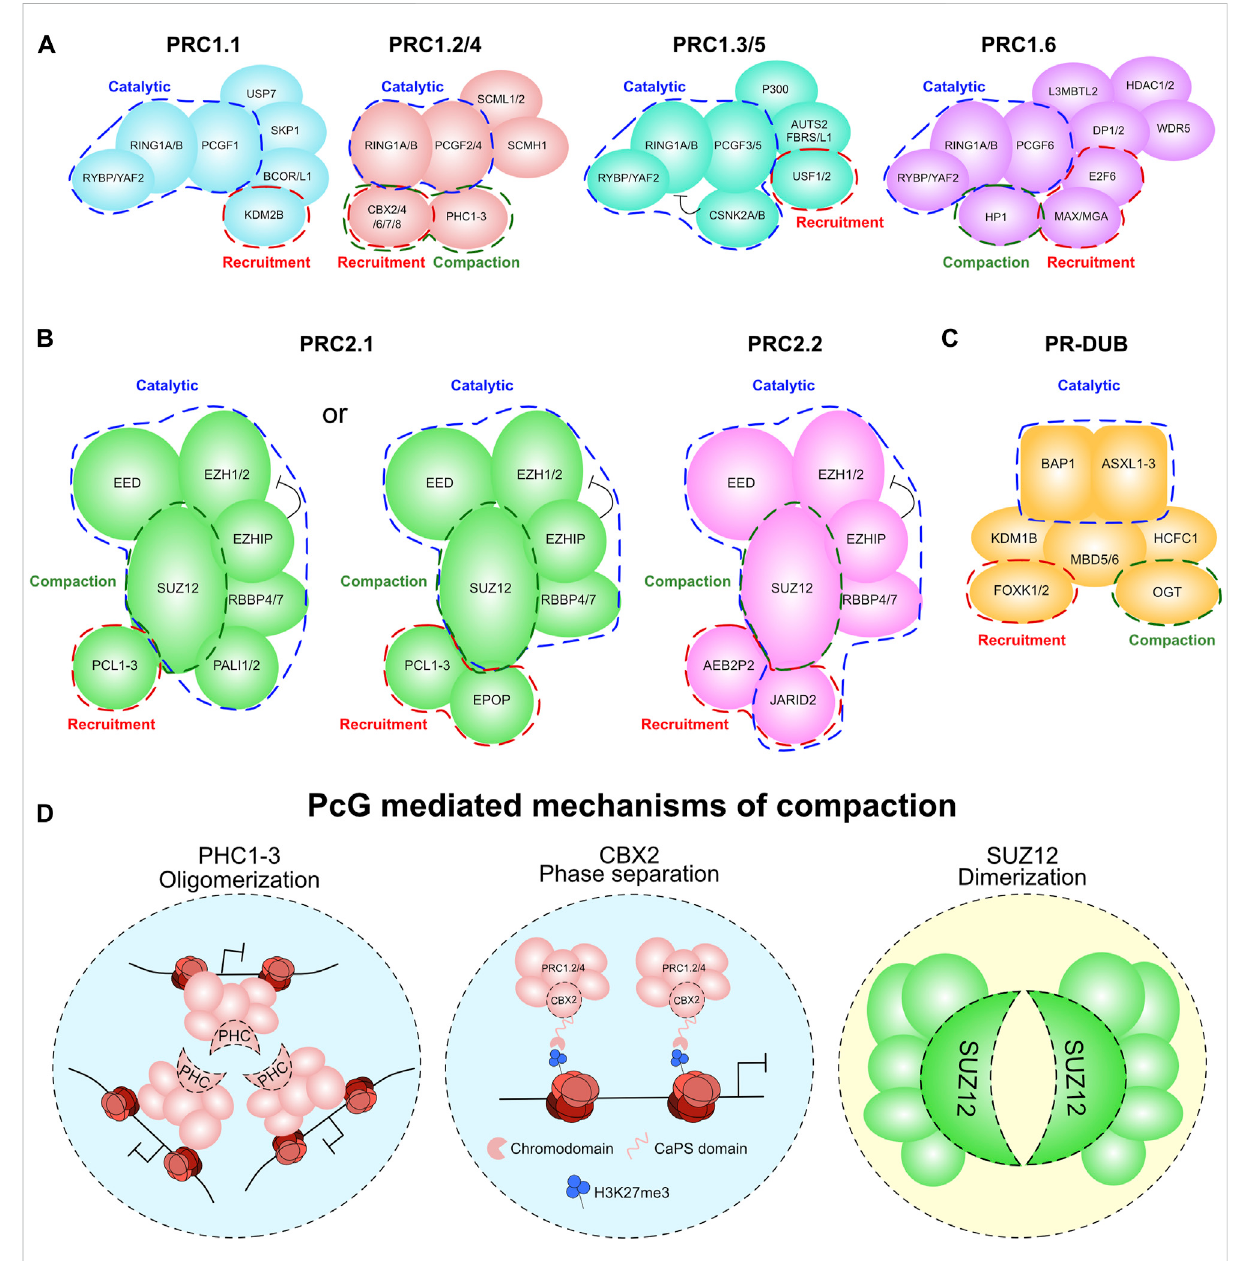
FIGURE 2 PcG complexes and their contribution to compaction. (A) The variable compositions of the PRC1 complex. Compaction related subunits are highlighted in green. Catalytic related subunits are highlighted in blue. Recruitment related subunits are highlighted in red. (B) The variable compositions of the PRC2 complex. Compaction related subunits are highlighted in green. Catalytic related subunits are highlighted in blue. Recruitmentrelated subunitsarehighlightedinred. (C) ThecompositionofthePR-DUBcomplex.Compactionrelatedsubunits arehighlighted in green. Catalytic related subunits are highlighted in blue. Recruitment related subunits are highlighted in red. (D) Model of the compaction mechanism for PcG proteins PHC1-3, CBX2 and